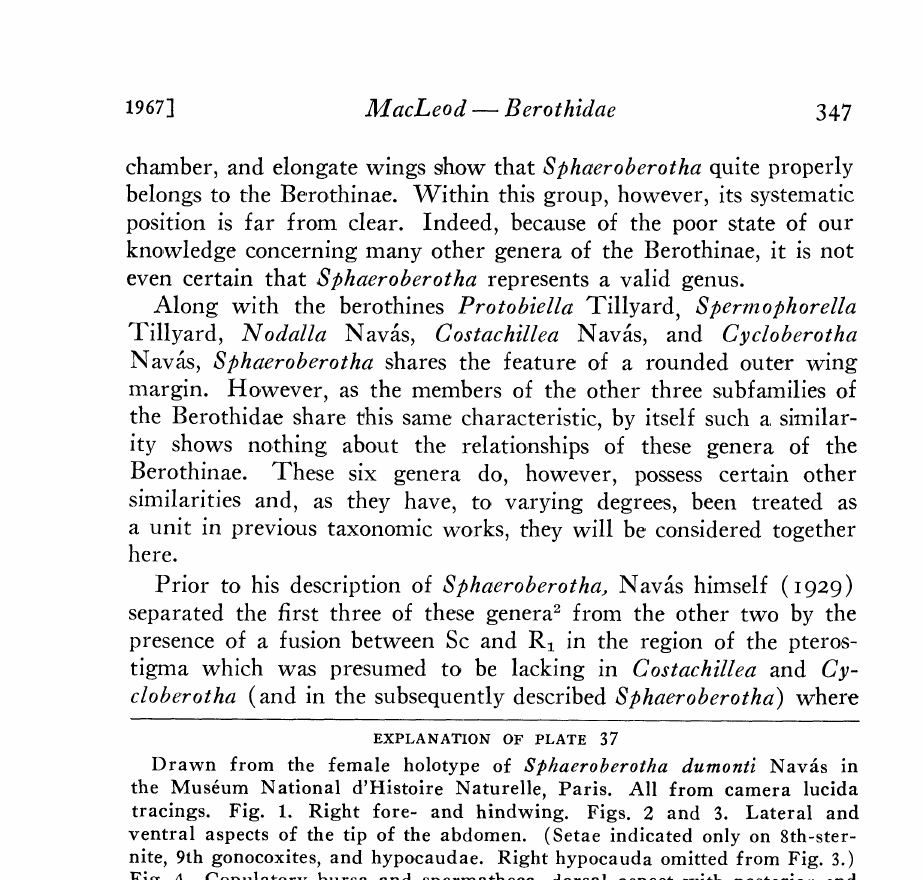
Fig. 4. Copulatory bursa and spermatheca, dorsal aspect with posterior end directed toward top of page. Abbreviations: a--anus; 1A, 2A, 3Am 1st, 2nd, 3rd anal veins; b--basal free piece of anterior median vein; coll. gl. mcollaterial gland duct and opening; cop. b. copulatory bursa; Cu--base of eubital vein; CuA-- anterior cubitus; CUP-- posterior eubitus; left. c. fertilization canal; 8 gcx, 9 gcxSth, 9th gonoeoxites; gen. ch.--genital chamber; gl? possible cuticular canals from spermathecal gland cells; gpr--gono- pore hye hypocauda M base of median vein MA anterior median vein; MP-- posterior median vein; ptpterostigma; Rl--first branch of radial vein; Rs--radial sector; rhvmvestige of recurrent humeral vein; 6S, 7S, 8S, 10Sm6th, 7th, 8th, 10th sternites; Sc--subcostal vein; sp--spermatheca; sp.d. mspermathecal duct; 6T, 7T, 8T6th, 7th, 8th tergites; 9T -t- ectmfused 9th tergite and eetoproct. ’Navfis further separated these three genera by placing Protobiella and SpermoI)horella in one tribe, the Spermophorellini, and Nodalla in a